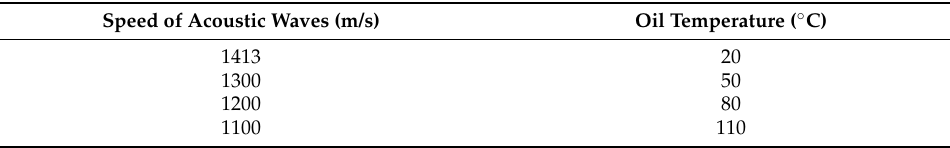
Table 1. Speed of AE Waves in Oil at Different Oil